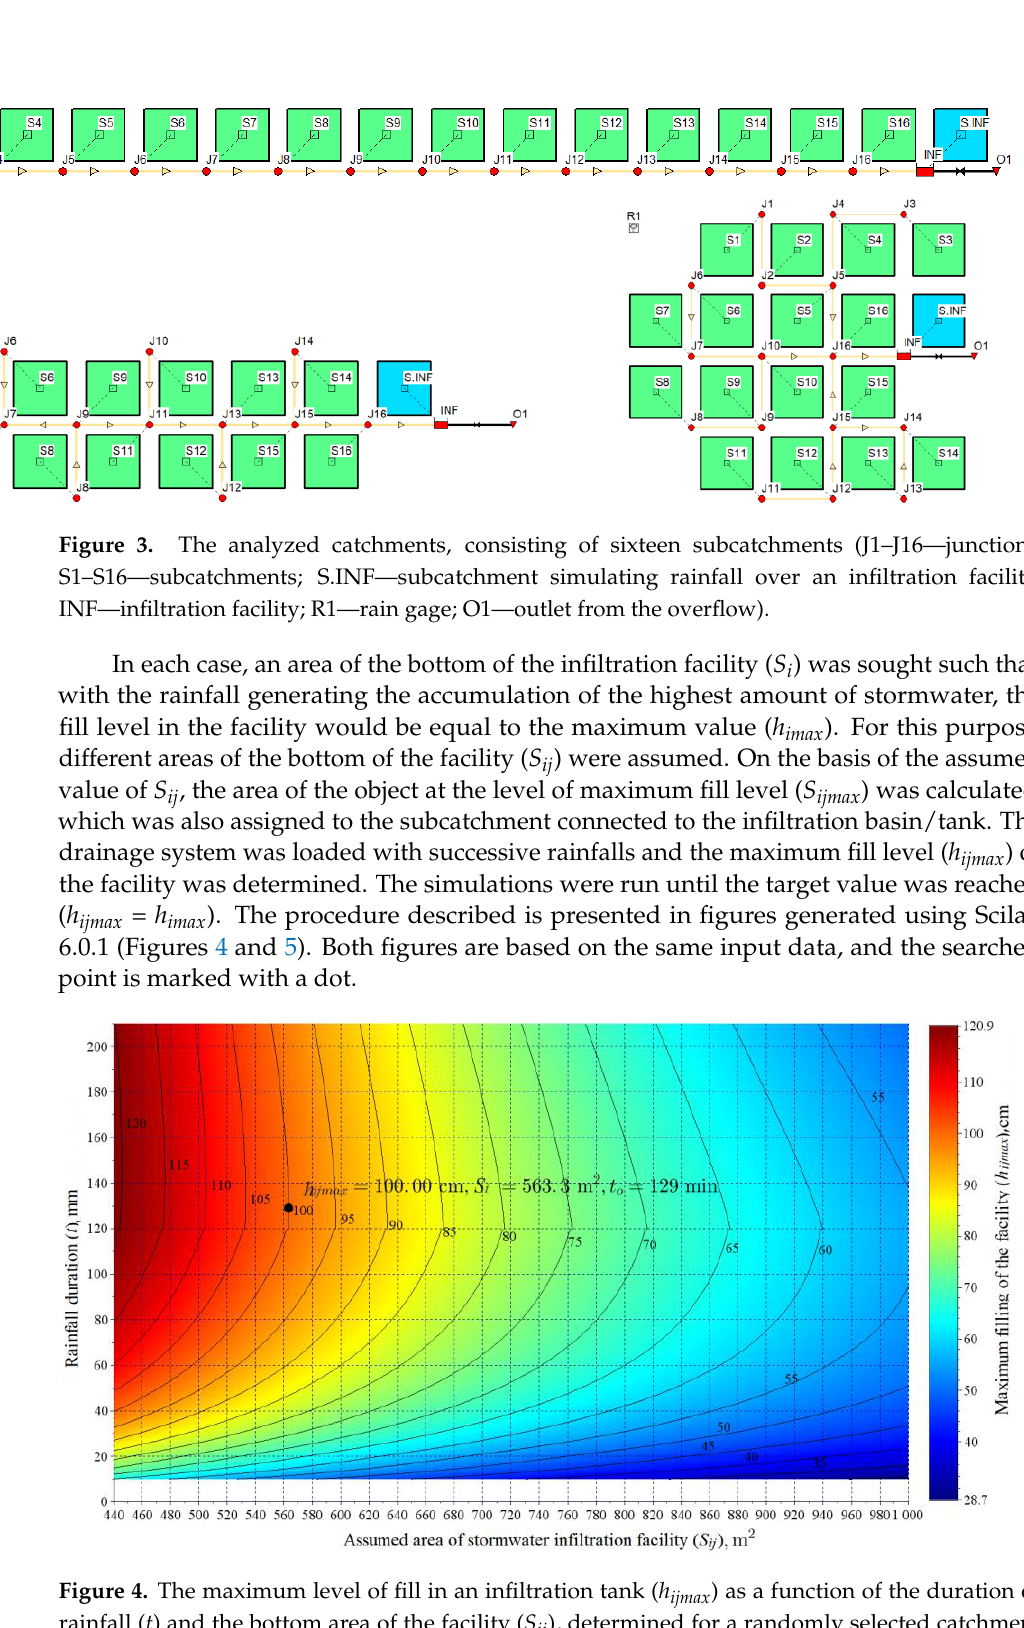
Figure 3. The analyzed catchments, consisting of sixteen subcatchments (J1 – J16 — junctions; S1 – S16 — subcatchments; S.INF — subcatchment simulating rainfall over an infiltration facility; INF — infiltration facility; R1 — rain gage; O1 — outlet from the overflow).